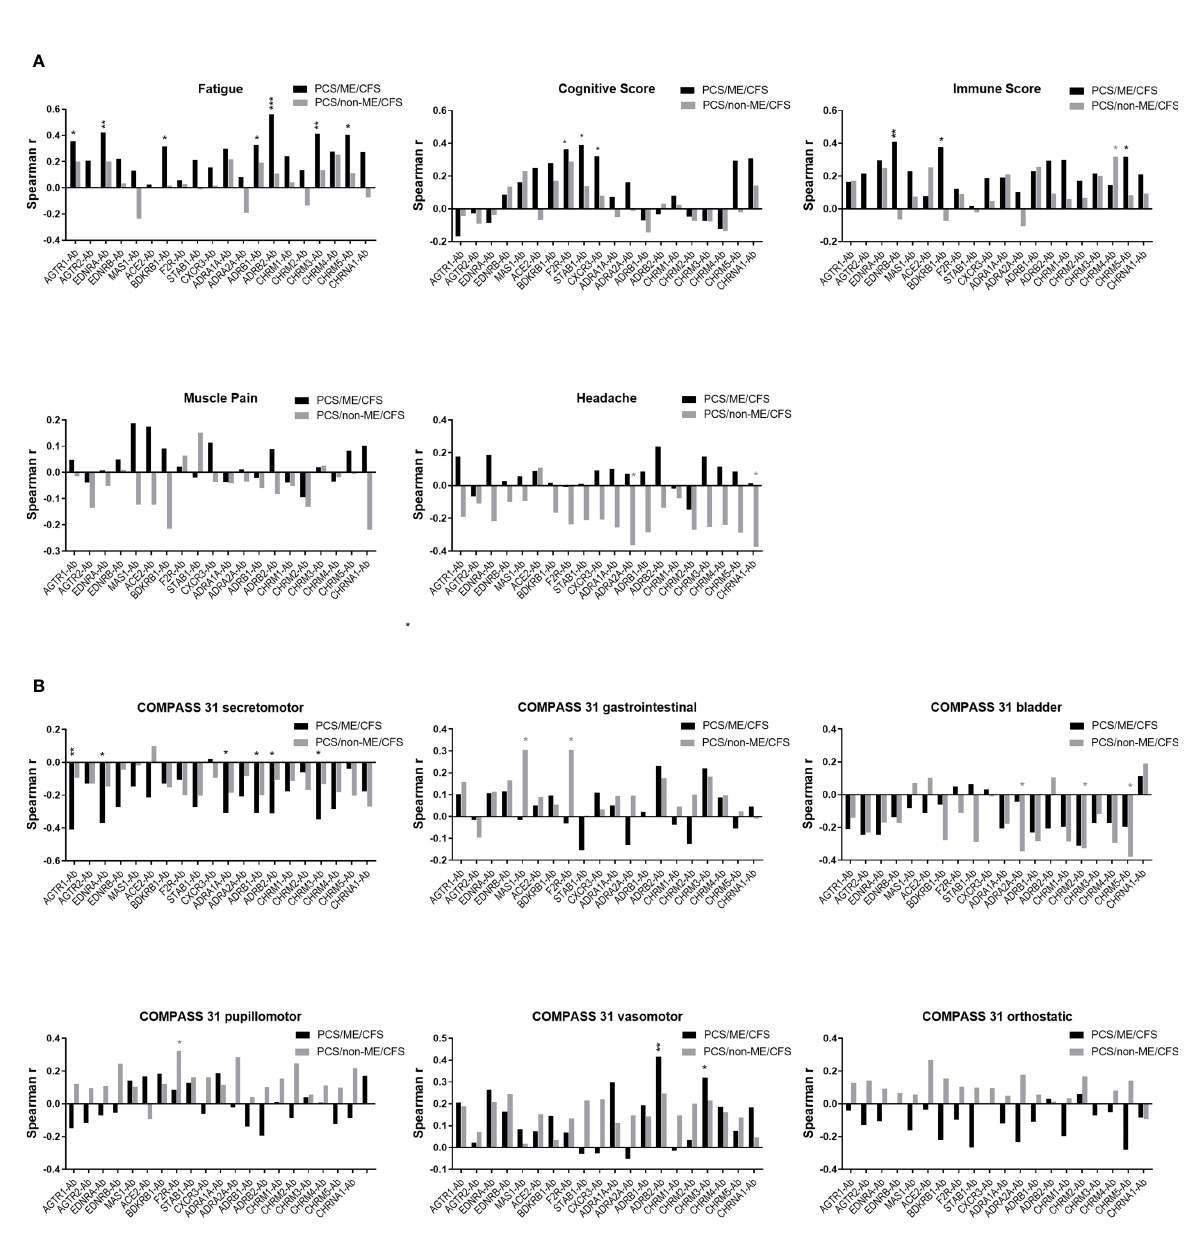
FIGURE 6 Correlation between autoantibody (-Ab) levels and clinical scores. Plots represent Spearman correlation coef fi cient (r) of correlation of Abs with (A) symptom scores and (B) autonomic symptom score assessed by COMPASS-31 questionnaire of PCS/non-ME/CFS (grey) and PCS/ME/CFS (black) patients. p values represented by: *p < 0.05, **p< 0.01 and